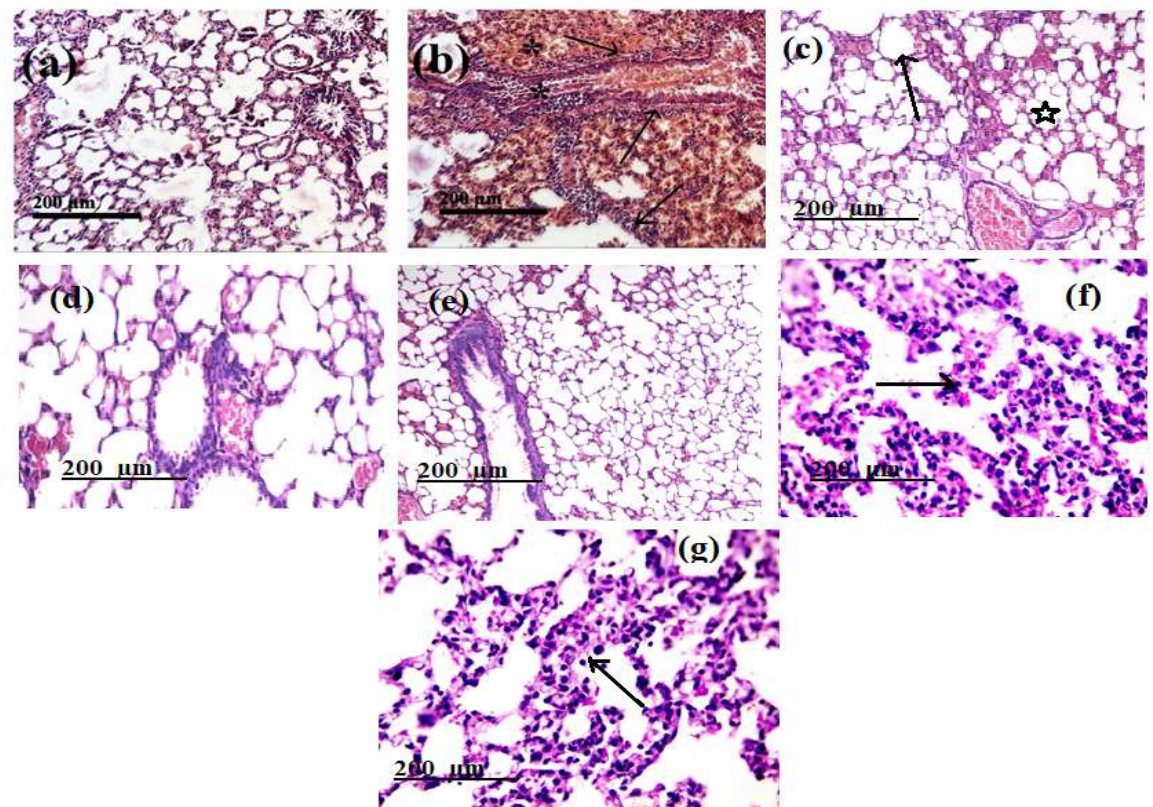
Figure 9. Sections stained with hematoxylin and eosin (H&E; 200 X) histological examination of rats’ lungs of different groups compared to control group ( a ) Negative control group (I); ( b ) Group II: positive control: (was received HgCl 2 (1 mg/kg) for a 15-day period. ( c ) Group III: Was treated with HgCl 2 (1 mg/kg.) + ferulic acid (50 mg/kg) for a 15-day period. (d) Group IV: Was treated with HgCl 2 (1 mg/kg.) + rutin (75 mg/kg) for a 15-day period. ( e ) Group V: Was treated with HgCl 2 (1 mg/kg.) + gallic acid (50 mg/kg) for a 15-day period; (f) Group VI: Was treated with HgCl 2 (1 mg/kg.) + chlorogenic acid (50 mg/kg) for a 15-day period. ( g ): Group VII: Was treated with HgCl 2 (1 mg/kg.) + P. dioica extract (50 mg/kg) for a 15-day period.